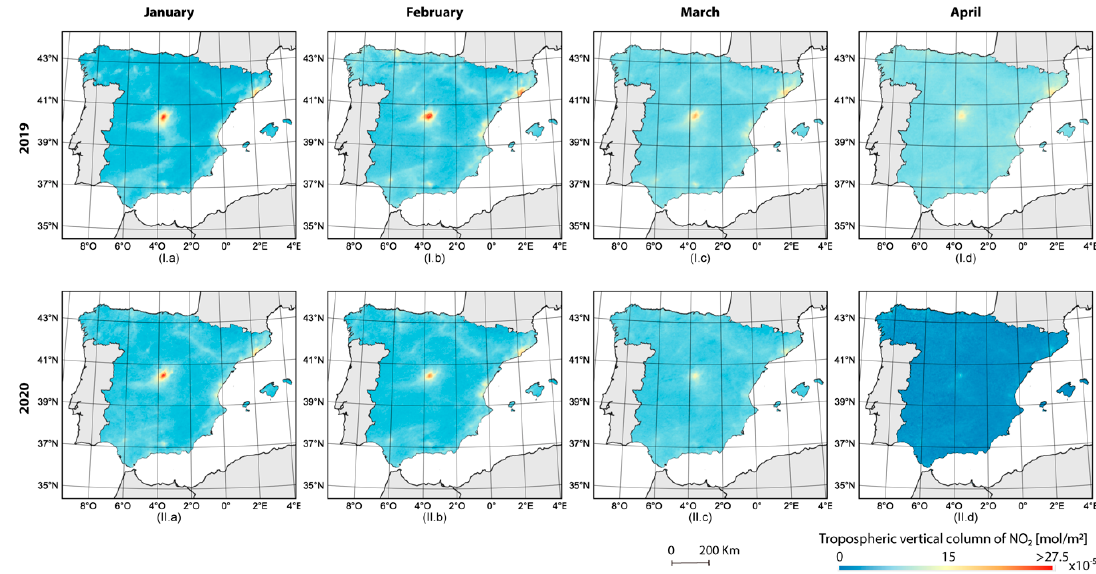
Figure 5. Monthly maps of average values of Tropospheric vertical column of NO 2 in Spain for the years ( I ) 2019 and ( II ) 2020 during the months of ( a ) January, ( b ) February, ( c ) March and ( d ) April.